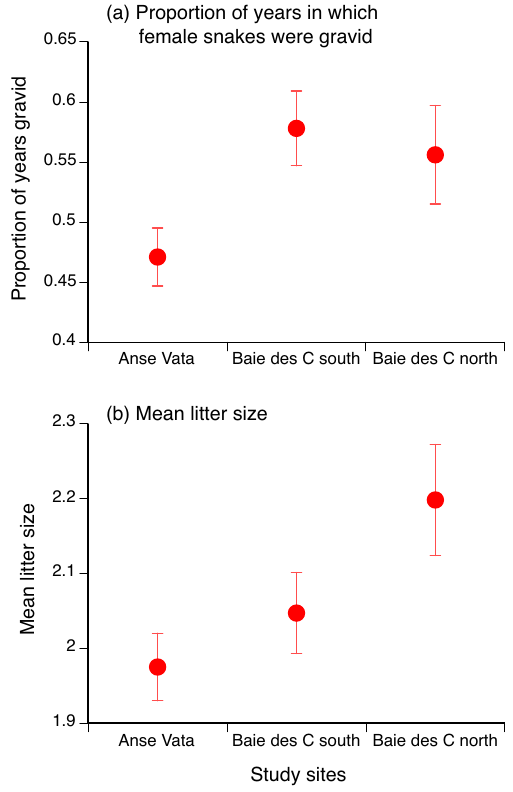
Figure 4. Variation among sites in reproductive output of adult female turtle-headed sea snakes ( Emydocephalus annulatus ). The upper panel ( a ) shows the proportion of years in which female snakes were gravid, based on females caught in at least two years. The lower panel ( b ) shows mean litter sizes, based upon all records. Both graphs show mean values and associated standard